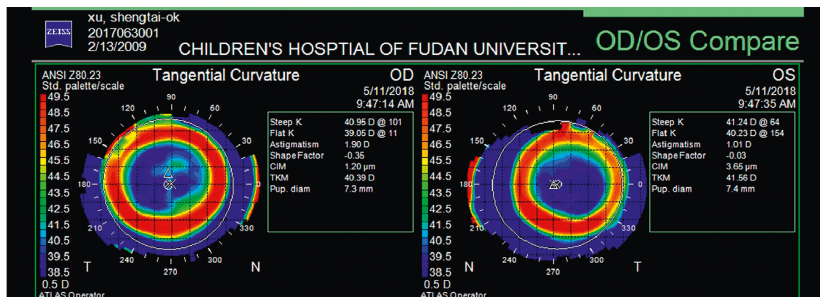
Figure 1: Corneal topography (tangent diagram) of an included subject as an example. x represents the center of corneal topography. Δ represents the corneal apex. ○ represents the pupil center.